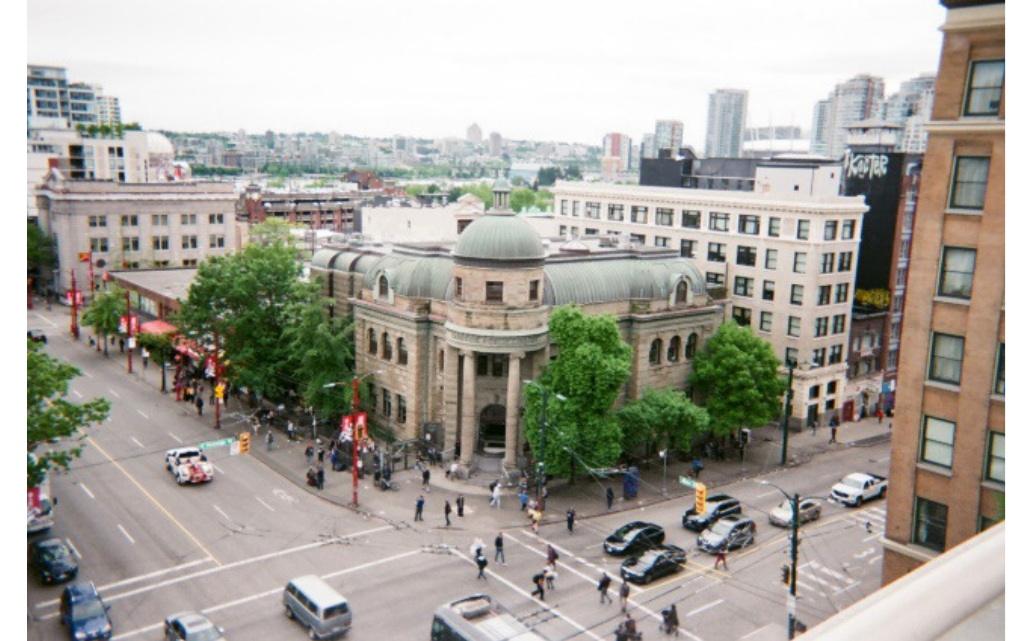
Figure 3. The Carnegie Centre. Source: Photo credits are due to participant